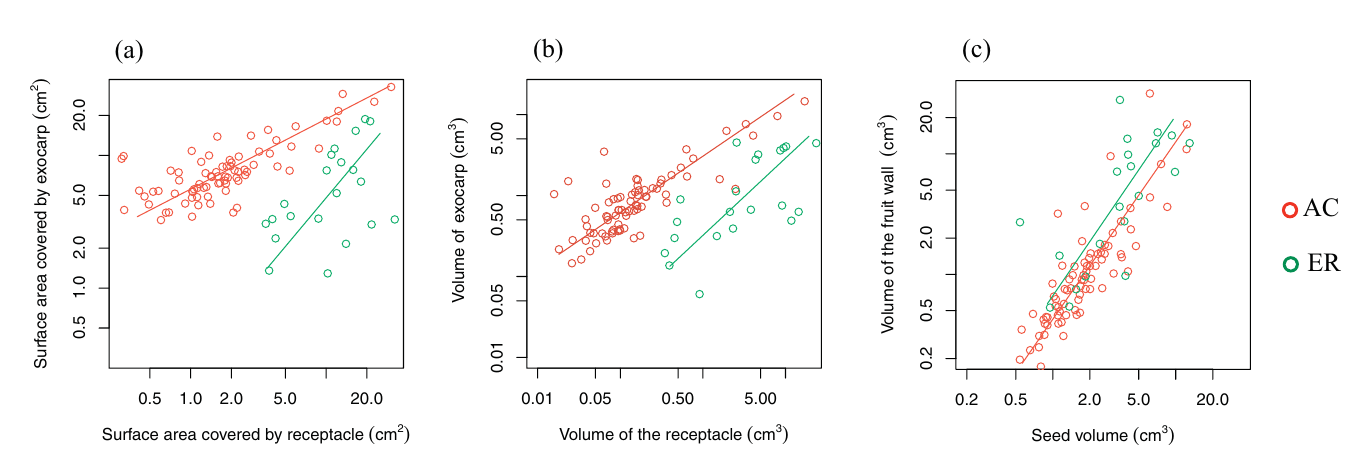
Fig 3. The interspecific variation of 98 species and between two fruit types. (a) The level of seed coverage by exocarp and receptacle. (b) The volume of exocarp and receptacle. (c) The fruit wall and seed volume. AC and ER stand for acorn and enclosed fruit type respectively. Each circle represents one species. The x and y axis of each graph are